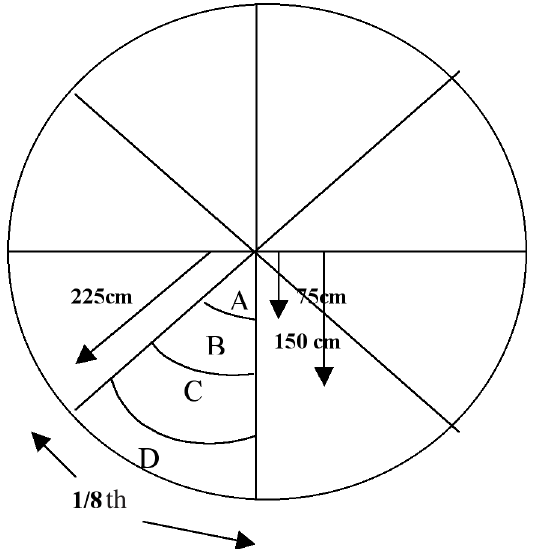
Fig. 1 - Scheme of the root sampling areas around the trunk (radial dis- tances: A = 0-75 cm; B = 75-150 cm; C = 150-225 cm; D = 225-300